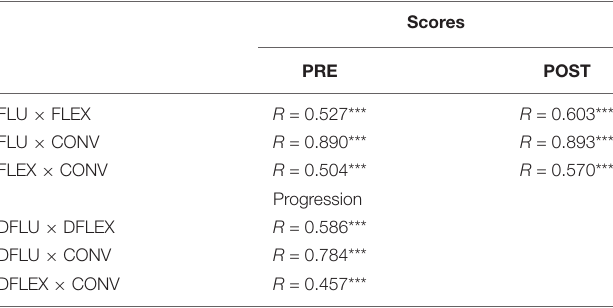
TABLE 8 | Coefficients of correlation between the FLU, FLEX, and CONV variables in the PRE and POST